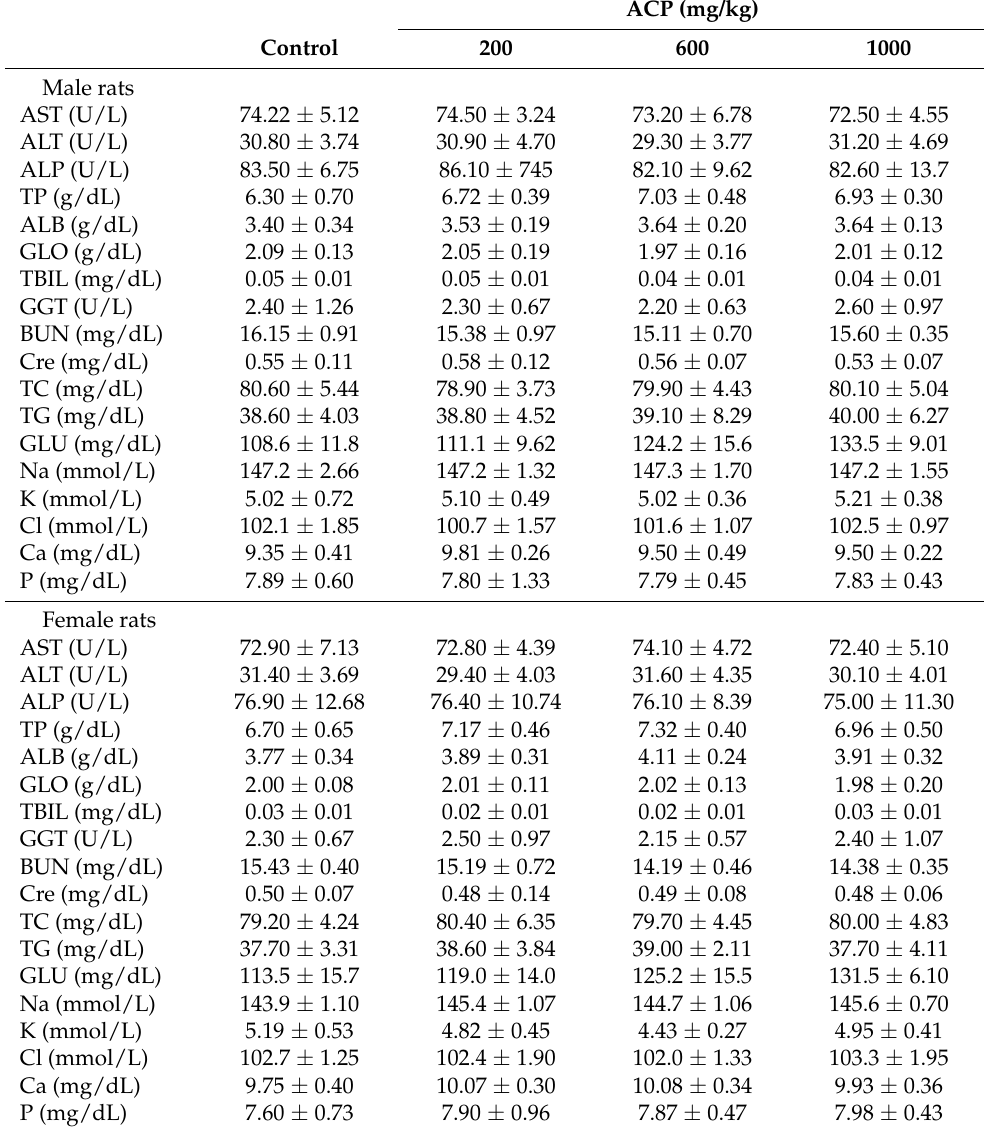
Table 4. Biochemical parameters of male and female rats treated with or without ACP for 90